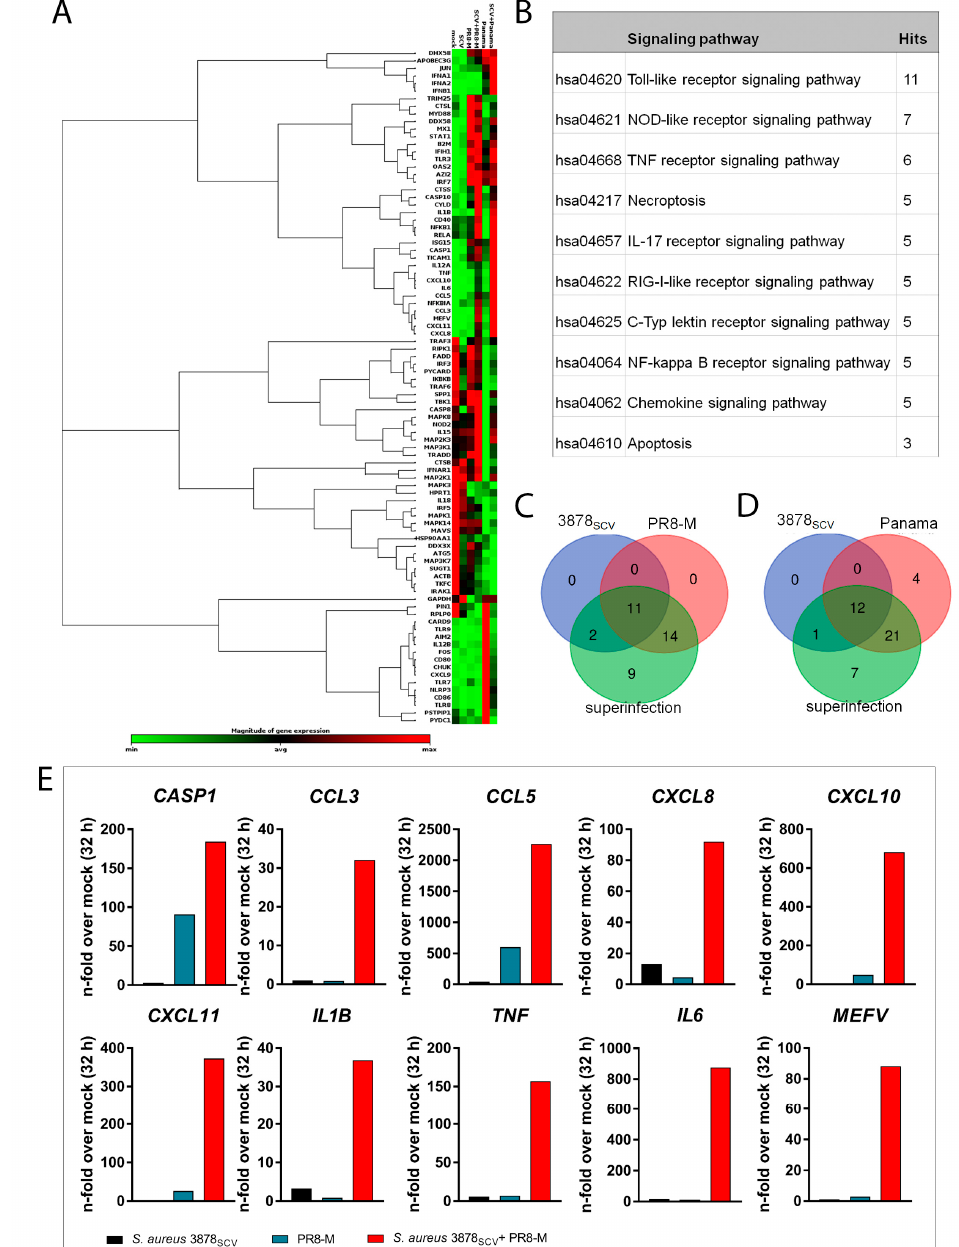
Figure 3. Gene expression analysis by RT 2 Profiler Array . ( A )–( E ) A549 lung epithelial cells were infected with S. aureus 3878 SCV (MOI = 0.01) for 24 h and/or super-infected with IV PR8-M (H1N1; MOI = 0.1) or IV Panama (H3N2; MOI = 0.01) for 32 h. Subsequently, RNA was isolated and further used to perform the RT 2 Profiler Array (Qiagen, Hilden, Germany). Ct-values were analyzed with the recommended QIAGEN web portal [26]. ( A ) A clustergram is shown, visualizing the up- and downregulated genes of the customized 84-gene array. ( B ) Ten potential signaling pathways are listed, which can be analyzed by the RT 2 Profiler Array with the correlating count of genes involved. The mapping was done by using the Kyoto Encyclopedia of Genes and Genomes (KEGG) mapper [38–40]. ( C ),( D ) A Venn diagram of the upregulated genes in a super-infection scenario with S. aureus 3878 SCV and IV PR8-M ( C ) or IV Panama ( D ) is shown. The analysis was performed by use of http://bioinformatics.psb.ugent.be/webtools/Venn/. ( E ) Gene expression of highly induced genes indicating an increased pro-inflammatory cytokine response. Values are shown as n-fold over mock (32 hpvi); ( n = 1); (hpvi = hours post-viral infection).